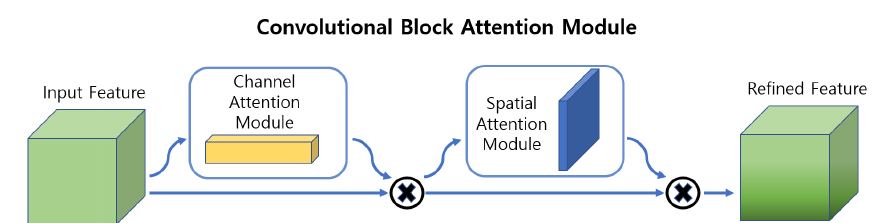
Figure 3. Architecture of the CBAM